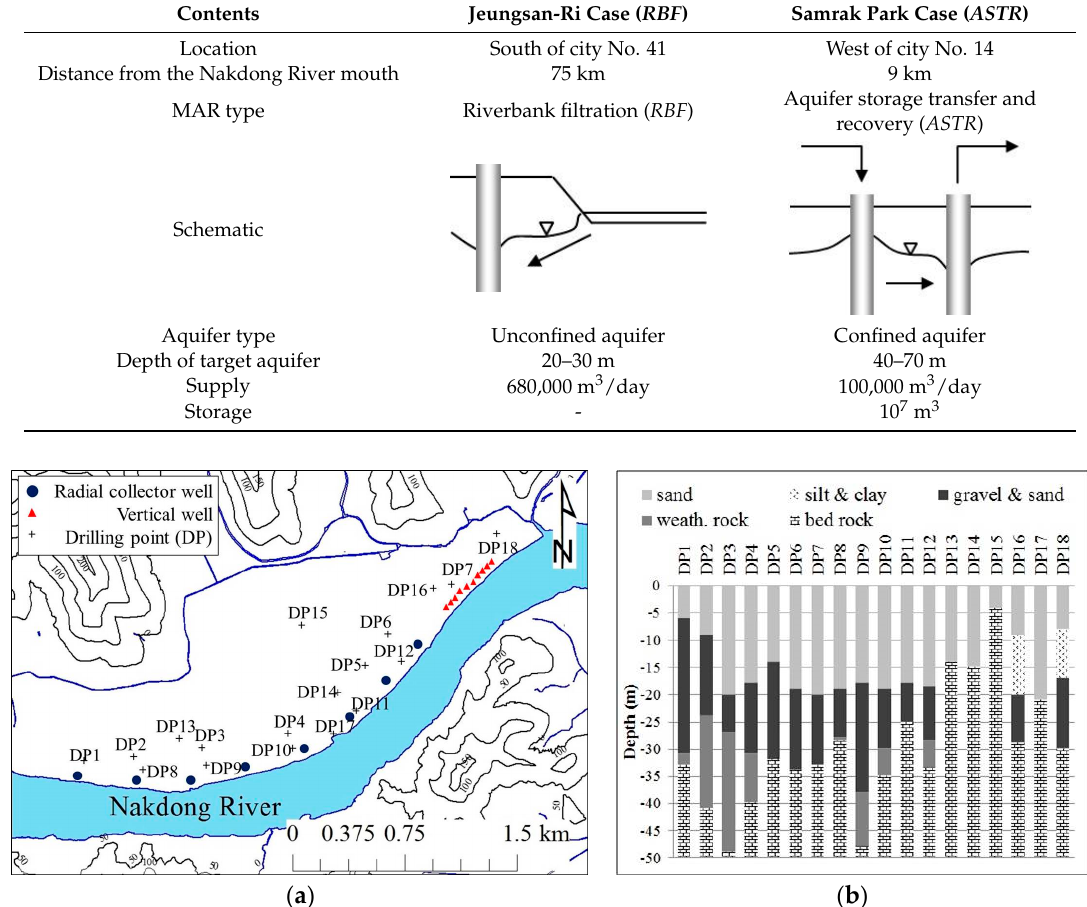
Figure 2. Wells ( a ) and boring log ( b ) at Jeungsan-ri RBF site [27].